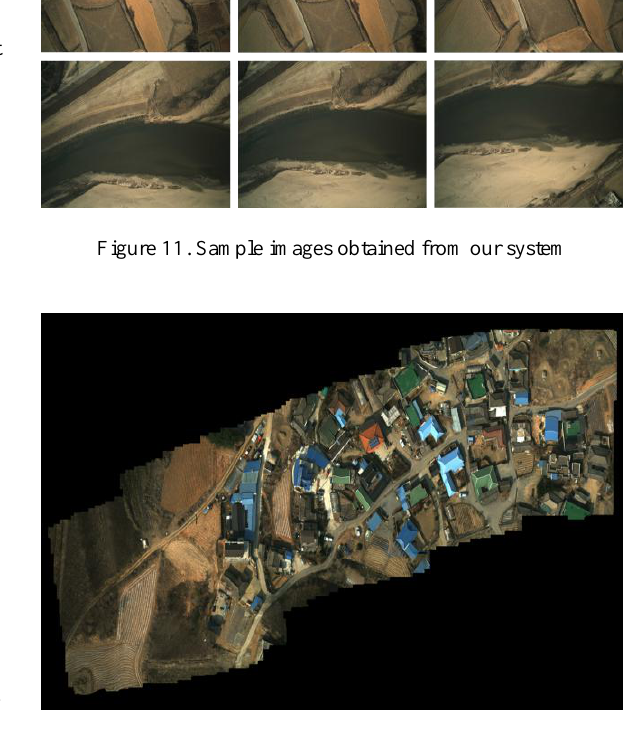
Figure 12. Mosaic